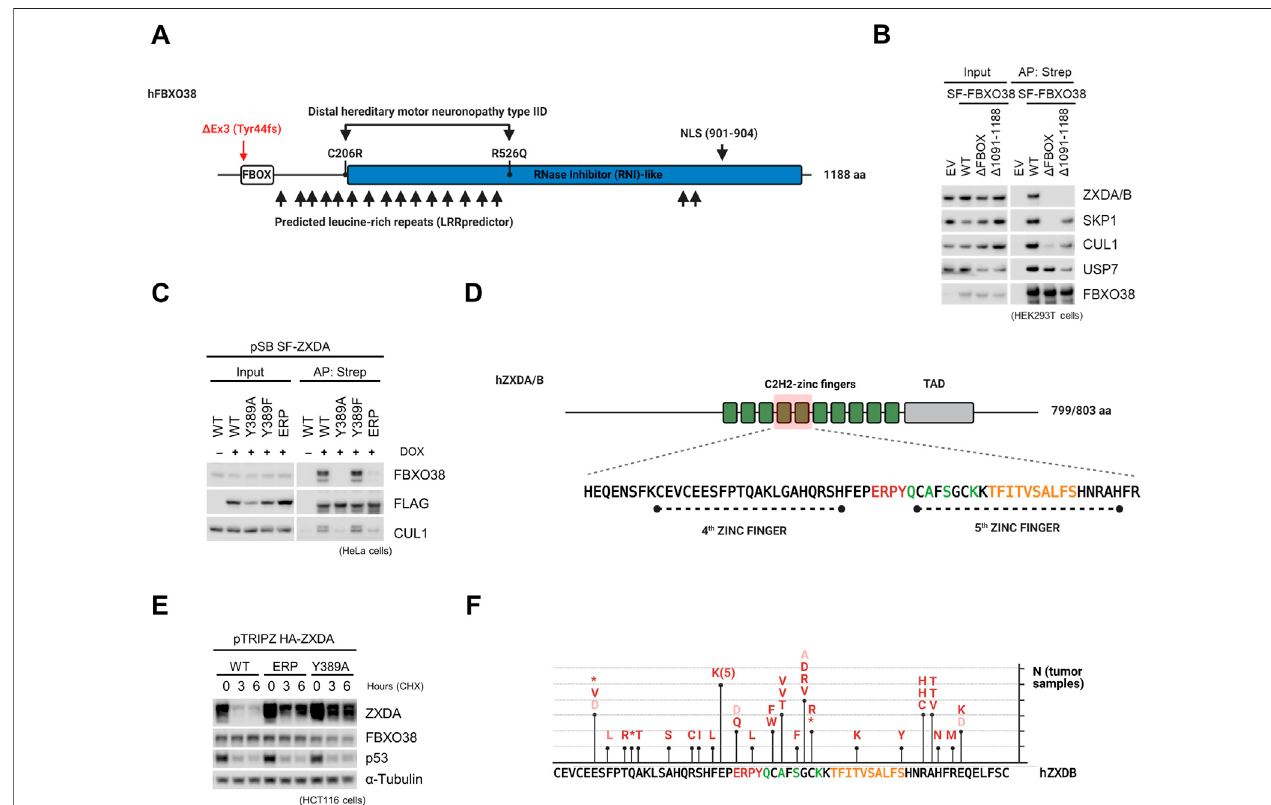
FIGURE 3 | FBXO38 associates with ZXDA/B via the zinc fi nger linker motif. (A) A scheme illustrating human FBXO38 structural features and disease-associated mutations.TheF-boxmotifislocatedintheN-terminusfollowedbypredictedleucine-richrepeats.Locationsofthetwomutations(C206RandR526Q)foundinpatients with distal hereditary motor neuronopathy type IID are depicted. The previously con fi rmed nuclear localization sequence (NLS) is located in the C-terminal part. Red arrowheadindicatesthesiteofframeshiftinFBXO38 Δ ex3/ Δ ex3 . (B) HEK293Tcellsweretransfected withStrepII-FLAG-taggedwild-type FBXO38(SF-FBXO38WT), FBXO38 lacking the F-box motif (FBXO38 Δ FBOX ) or C-terminus (FBXO38 Δ 1091-1188 ), treated with MLN4924 6 h prior to collecting, lysed, and subjected to af fi nity puri fi cation (AP) using Strep-Tactin resin. Inputsrepresent 1% ofthe whole-cell lysates subjected to AP. (C) HeLa cells with the inducible expression of SF-ZXDA and its mutants were treated with doxycycline for 24 h where indicated. Whole-cell lysates were subjected to af fi nity puri fi cation (AP) using Strep-Tactin resin and immunoblotted as indicated. Inputs represent 1% of the whole-cell lysate subjected to AP. (D) A schematic representation of human ZXDA and ZXDB proteins. Both containtenC2H2Zinc fi ngers(greenboxes)followedbyapreviouslyreportedtranscriptionalactivationdomain(TAD)(Al-Kandarietal.,2007).Thezinc fi ngersimportant for FBXO38-interaction are red-tinted. Amino acids encompassing this region are depicted below, with a zinc fi nger linker necessary for FBXO38-interaction highlighted in red. Mutations of amino acids marked in yellow had a negative effect on FBXO38 interaction (degron). The green-labeled amino acids differ between ZXDA/B and ZXDC. (E) HCT116 cells with inducible expression of HA-tagged ZXDA and its mutated forms were incubated in the presence of doxycycline for 24 h and then treated withcycloheximide(CHX) fortheindicatedtime. (F) ZXDBmutationsidenti fi ed intumor samples(The CancerGenomeAtlas cohort).Mutationsfoundinthevicinityofthe FBXO38-dependent degron are depicted (deleterious mutations — red; synonymous or conservative mutations — orange). The ZXDB sequence is outlined below with amino acids highlighted as in (D) .